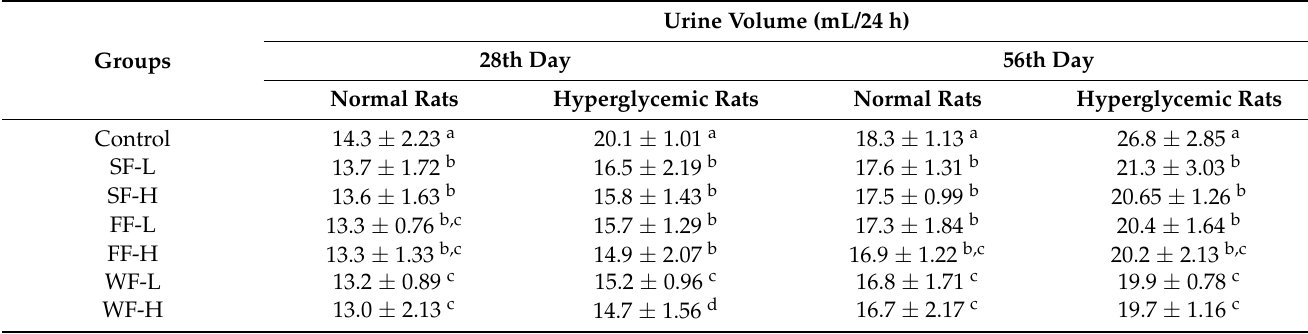
Table 4. Impact of bitter melon supplementation on urine volume of